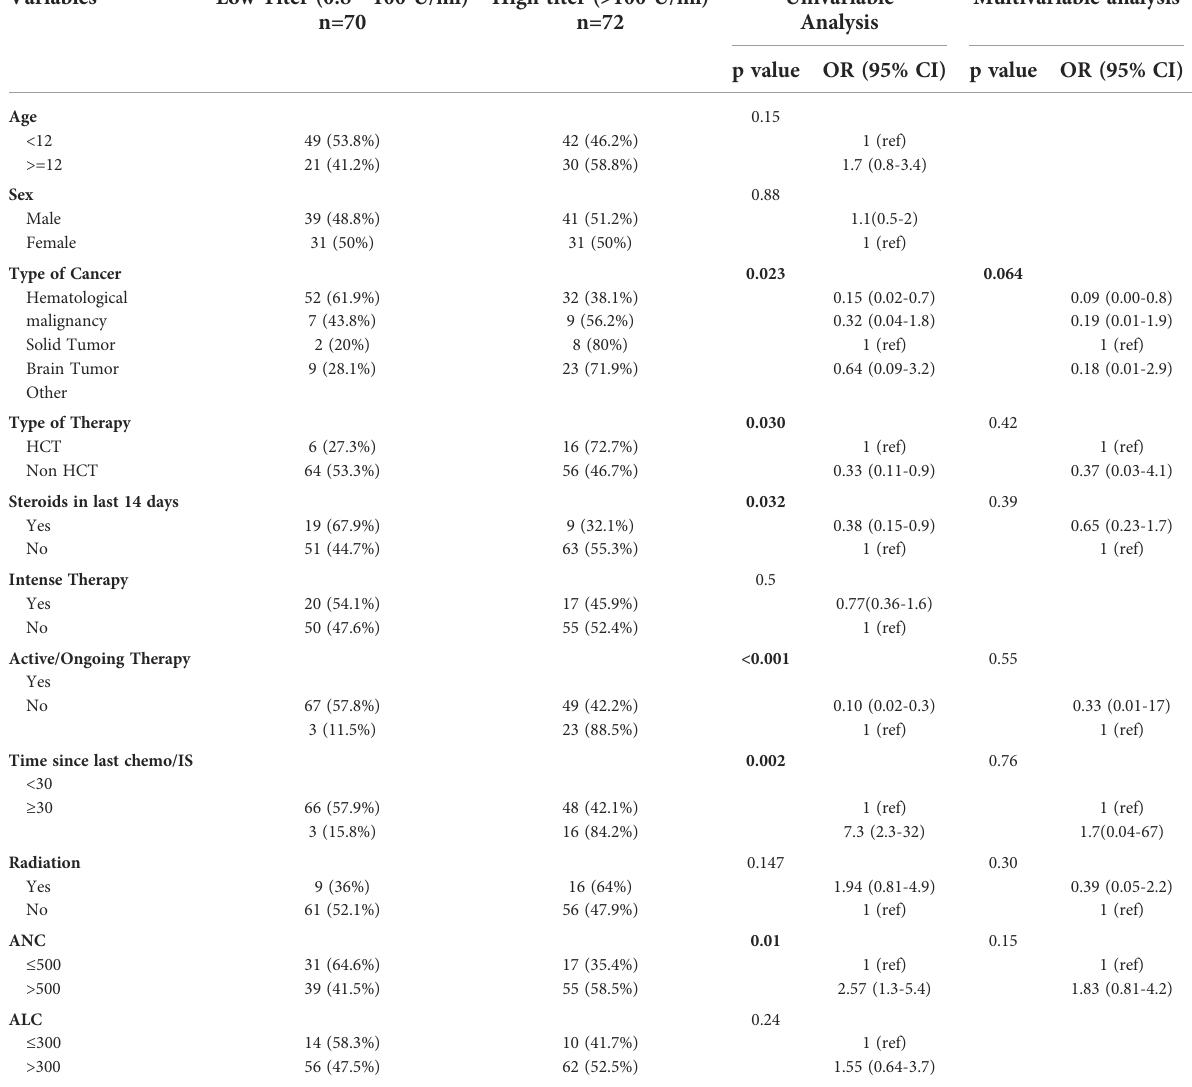
TABLE 3 Univariable and multivariable analysis for seroconversion (n=142